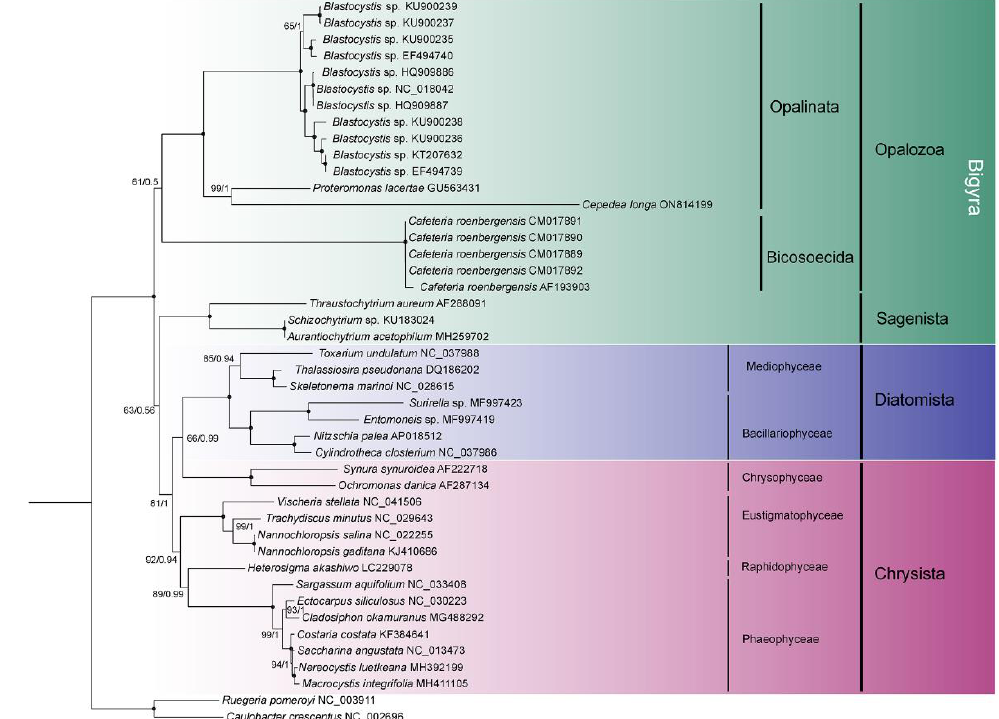
Figure 5. The phylogenetic tree of Stramenopiles inferred using the dataset comprising concatenated nad sequences of mitochondrial genomes. Black dots represent 100% bootstrap support values and 1.00 posterior probability values. The tree is rooted using two bacterial species.